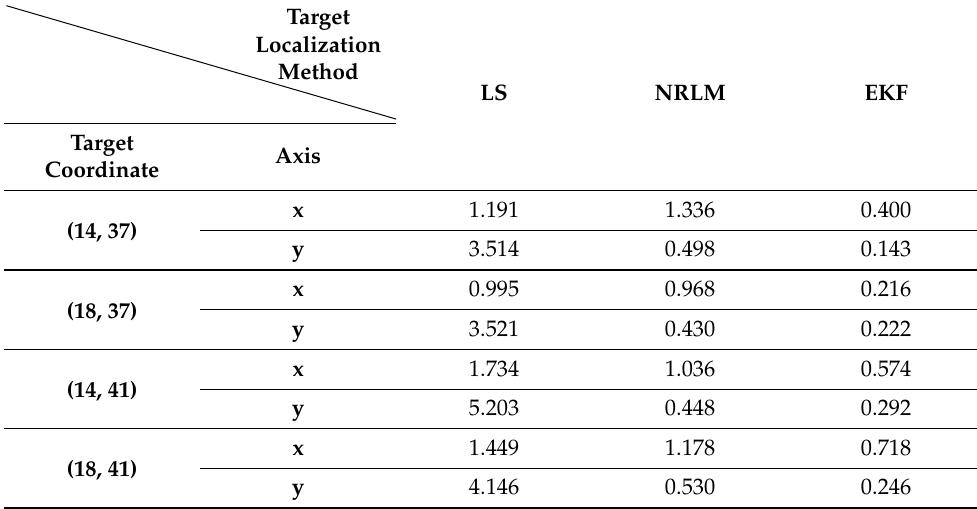
Table 4. Case 2—Standard deviations of target coordinates ( X, Y ) for human index finger (unit: